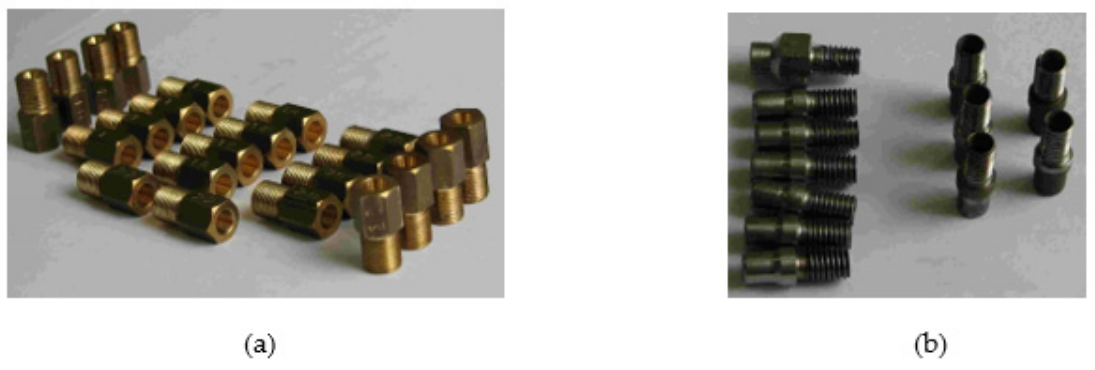
Figure 13. Sets of nozzles ready for well cleaning. ( a ) Cavitation nozzles, ( b ) hydrodynamic conic nozzles.